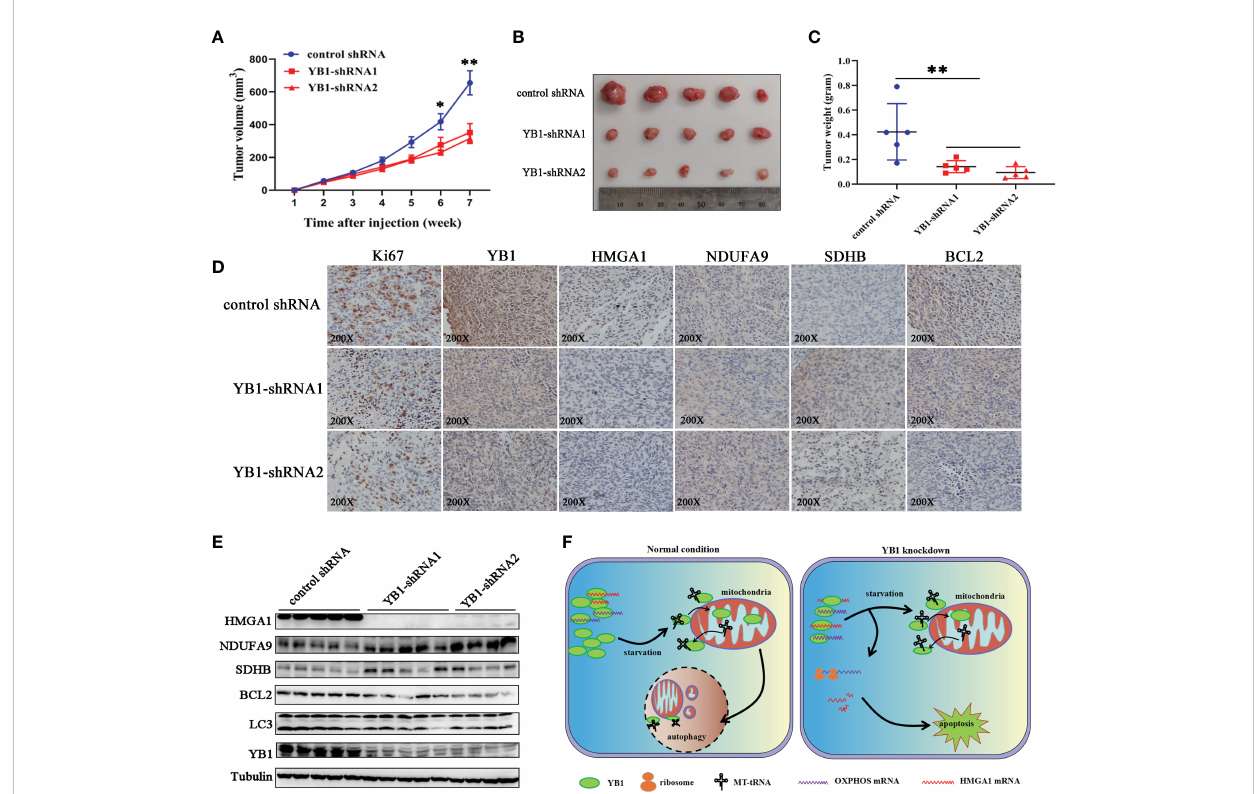
FIGURE 7 YB1 promoted tumorigenesis of breast cancer cells. (A) The statistics of xenograft volume in nude mice at different times. Breast cancer cells with different YB1 expression levels were subcutaneously injected into nude mice, and the volumes of tumors were monitored at different times. n = 5, *p < 0.05, **p < 0.01. (B) The representative pictures of solid tumors collected from nude mice. (C) Solid tumor weight analysis. n = 5, **p < 0.01. (D) Immunohistochemical analysis of YB-1-regulated proteins in breast cancer xenografts. Speci fi c antibodies were used to detect each protein (brown), and nuclei were stained with hematoxylin (blue). (E) The levels of YB1-regulated proteins in xenografts were investigated through Western blot. (F) Proposed working model for the role of starvation-induced YB1-bound RNA replacement by mitochondrial RNA in regulating cell autophagy and apoptosis in breast cancer